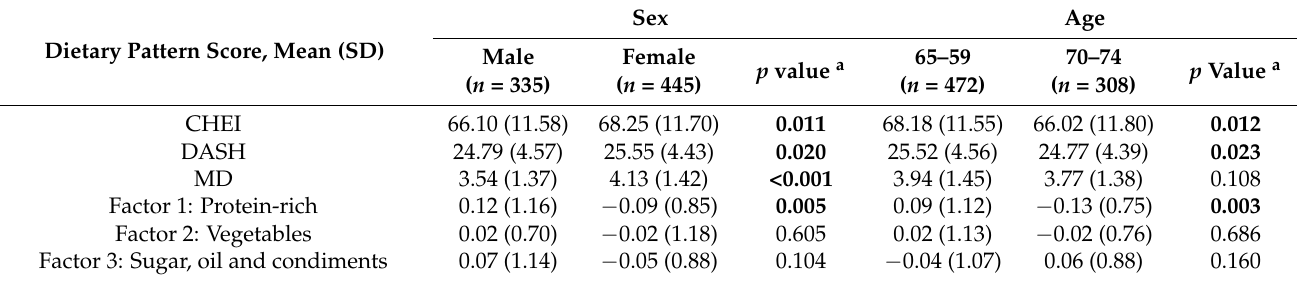
Table 3. Dietary pattern scores of participants by sex and age groups (n = 780).